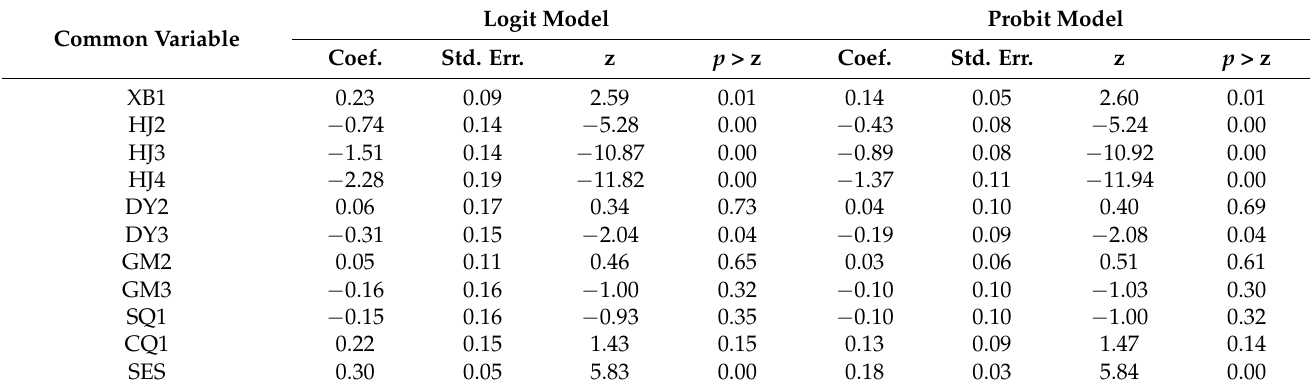
Table 7. Table of logit and probit regression model results for covariates between only-child and non-only-child students (using fifth graders as an